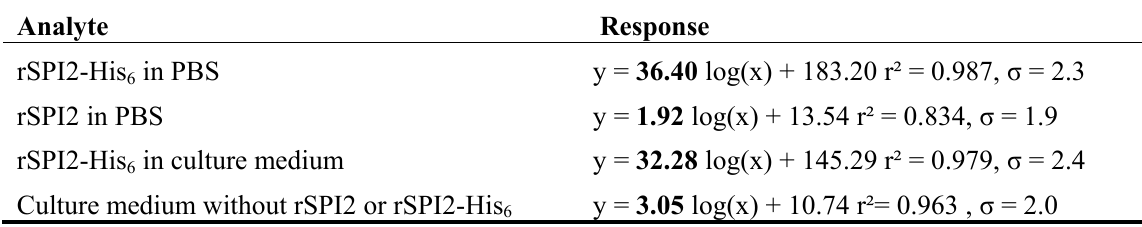
Table 3. SPR responses of the immunosensor incorporating Anti-His IgG F(ab’)